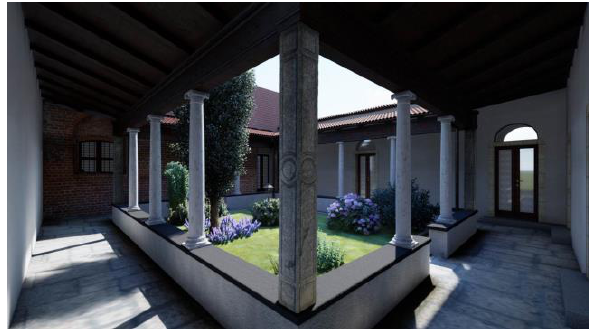
Figure 10. View of the virtual environment